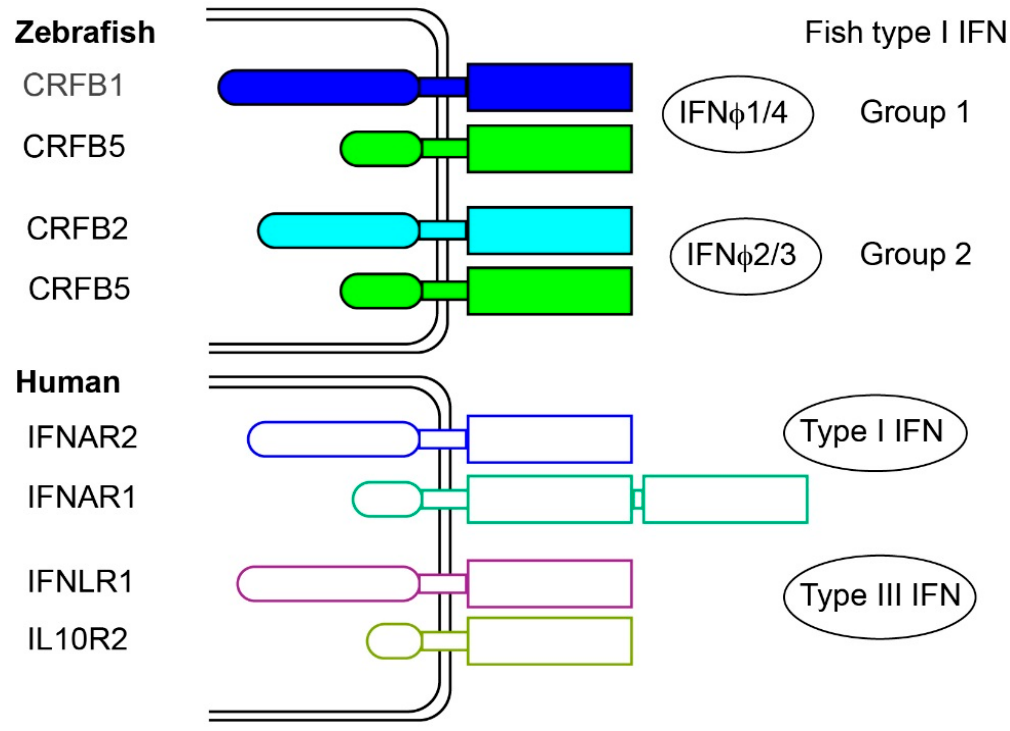
Figure 2. Receptors of virus induced IFN in zebrafish and human. Adapted from [21]. Intracellular regions are represented by round boxes, and D200 domains by rectangular boxes. IFN binding to each receptor are represented on the right.